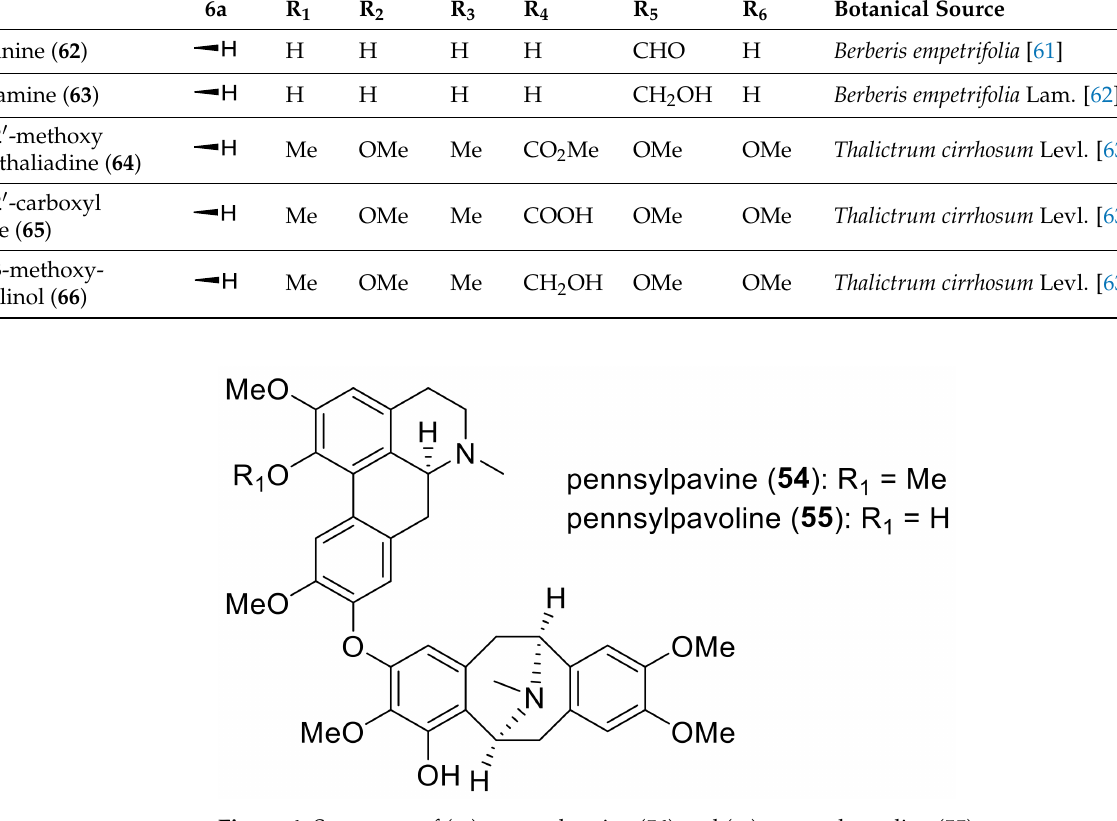
Figure 4. Structures of ( − )-pennsylpavine ( 54 ) and ( − )-pennsylpavoline ( 55